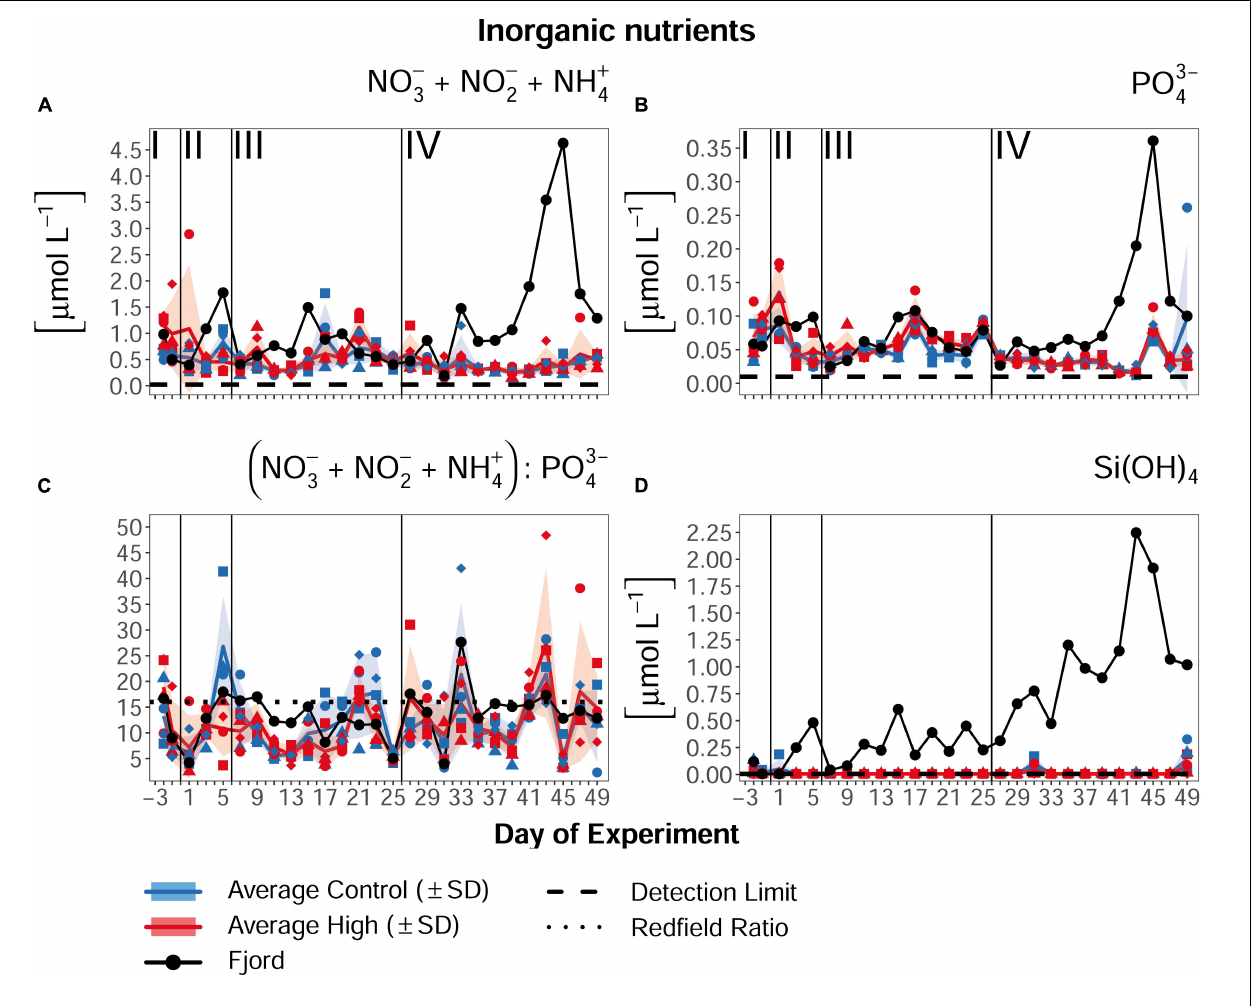
FIGURE 5 | Nutrient concentrations of (A) total N = nitrate + nitrite + ammonium (NO - 3 + NO - 2 + NH + 4 ), (B) phosphate ( PO 3 − 4 ), (C) total N :P ratio, and (D) dissolved silica Si ( OH ) 4 over the course of the experiment. Lines, symbols, and colors are used as described in Figure 4 . For assignment of symbols to the individual mesocosms see Table 1 . Roman numerals label the different phases of the experiment separated by vertical lines (for description of phases see Table 2 ). Figure created with the ggplot2 package in RStudio (Rstudio Team, 2016; Wickham et al.,